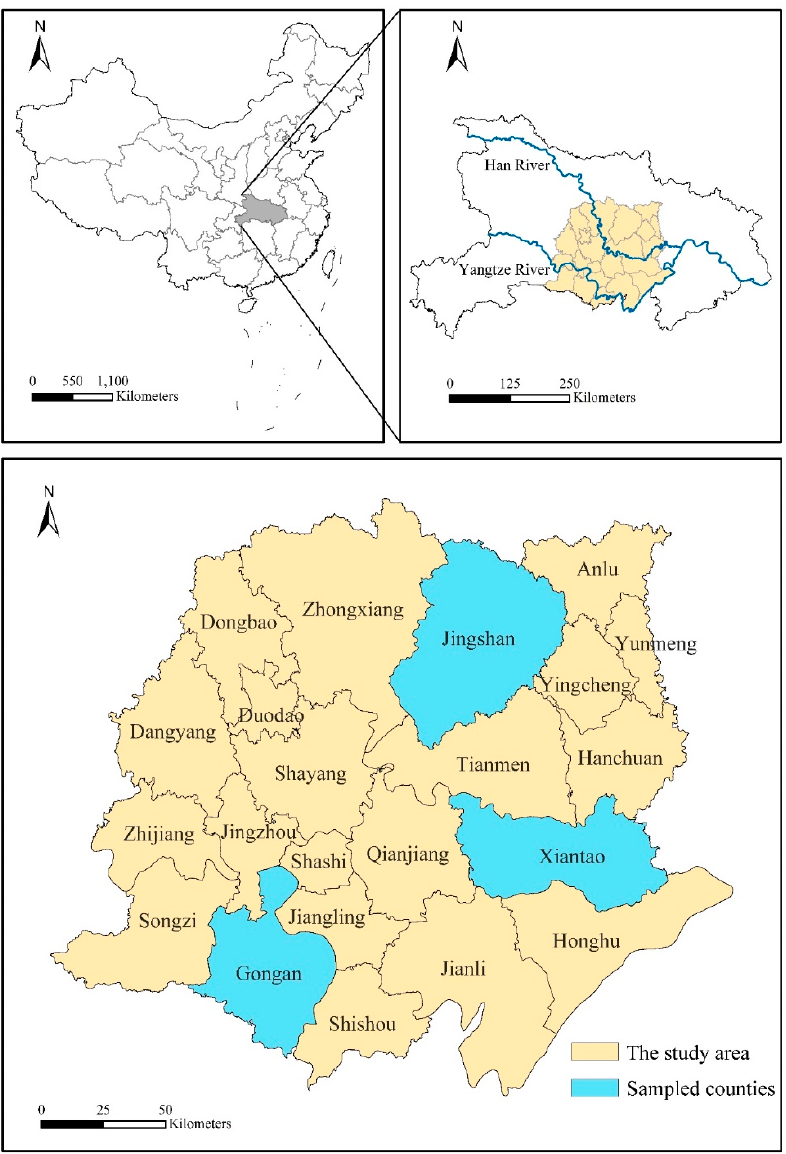
Figure 3. Location of the study area and sampled counties.